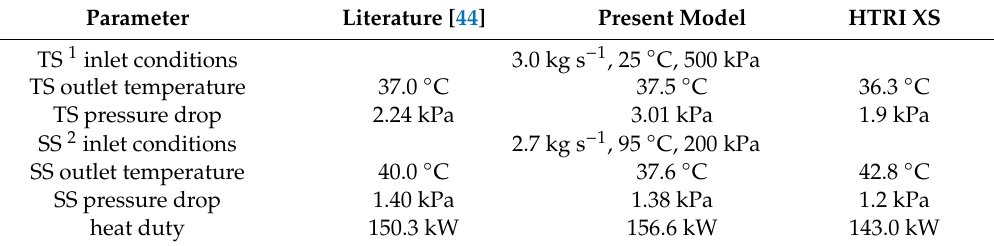
Table 2. Parameters of the air-to-water heat exchanger (for the remaining construction data, etc., please see [44]) and the corresponding results obtained using the present model and HTRI Xchanger Suite (“HTRI XS”).